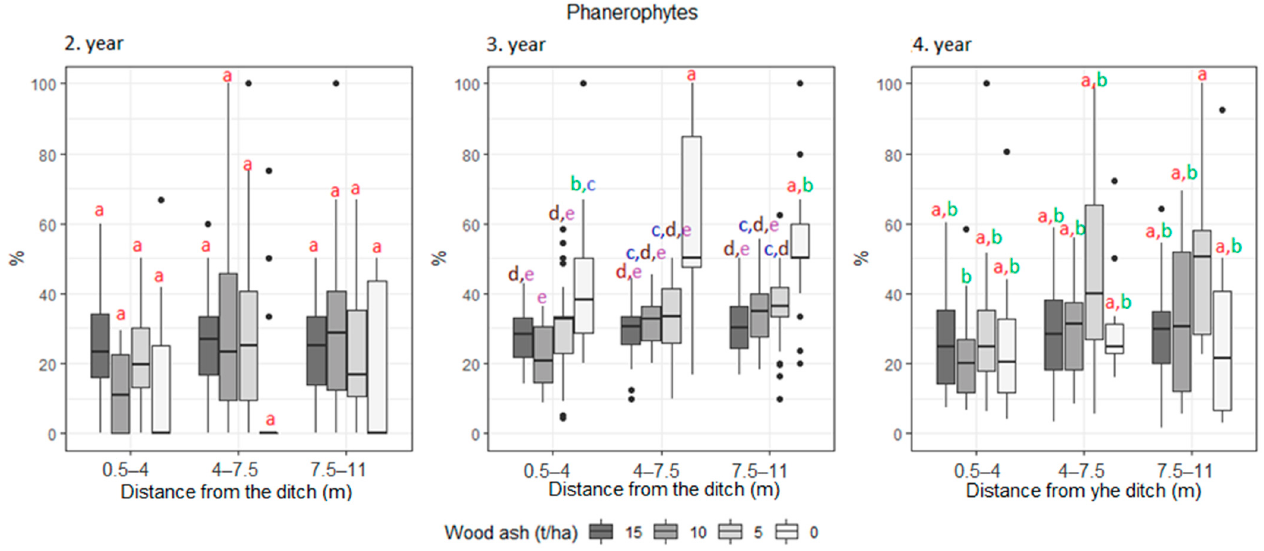
Figure A4. Percentage of plants with phanerophyte growth form from the total vegetation cover, depending on the distance from the drainage ditch and the dose of wood-ash fertiliser. Different letters (a, b, c, d, e) indicate significant differences between groups, p < 0.05 according to the Tukey HSD test.